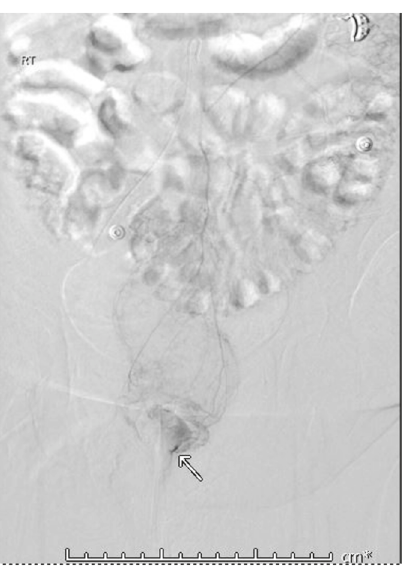
Figure 1: Mesenteric arteriography with contrast extravasation in the rectum.